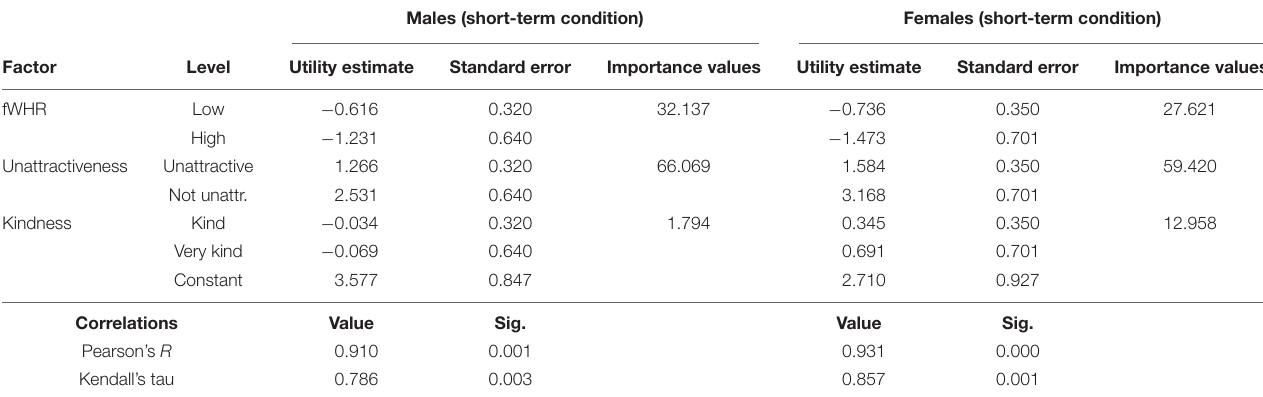
TABLE 3 | Results conjoint analysis by male ( n = 160) and female ( n = 220)